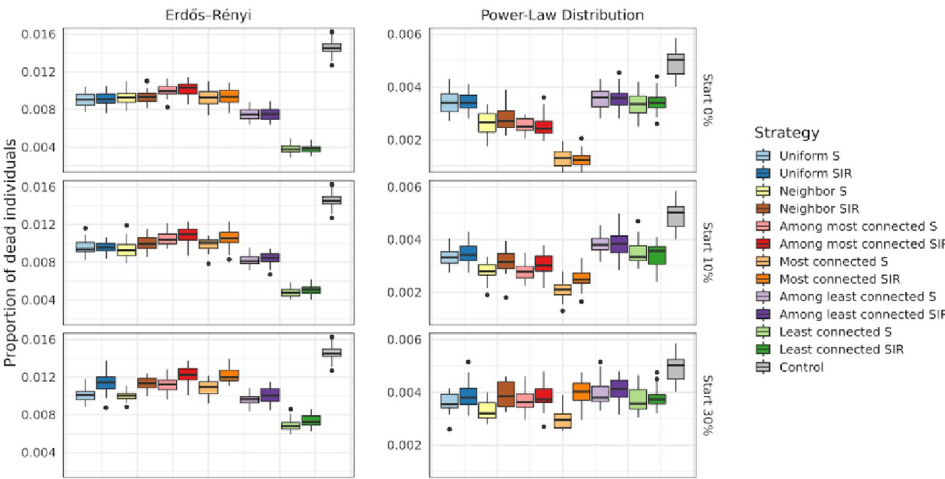
Fig 5. Proportion of deaths, for an effectiveness of 90% and for different values of t V (top panels vaccination starts at 10% and bottom panels at 30%). The horizontal lines in the middle of the boxes show the mean values among all simulations, the upper and lower edges of the boxes are the quantiles q0.25and q0.75 corresponding to 75% respectively 25%. The vertical lines reach until q0.25–1.5 � (q0.75-q0.25) downwards and until q0.75+1.5 � (q0.75-q0.25). The points represent outliers (i.e., simulations whose results are